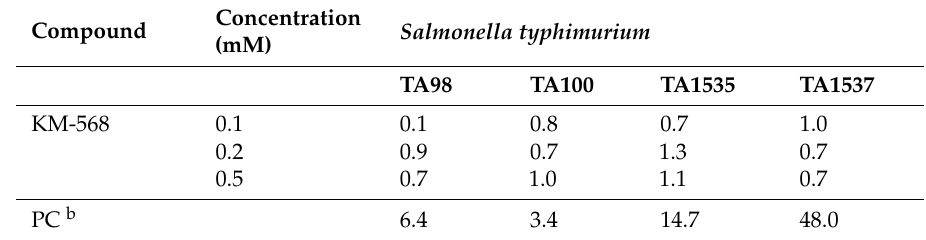
Table 11. Results of mutagenicity assessment of KM-568 in the Ames microplate format (MPF) assay presented as fold induction of the number of positive wells over baseline a .